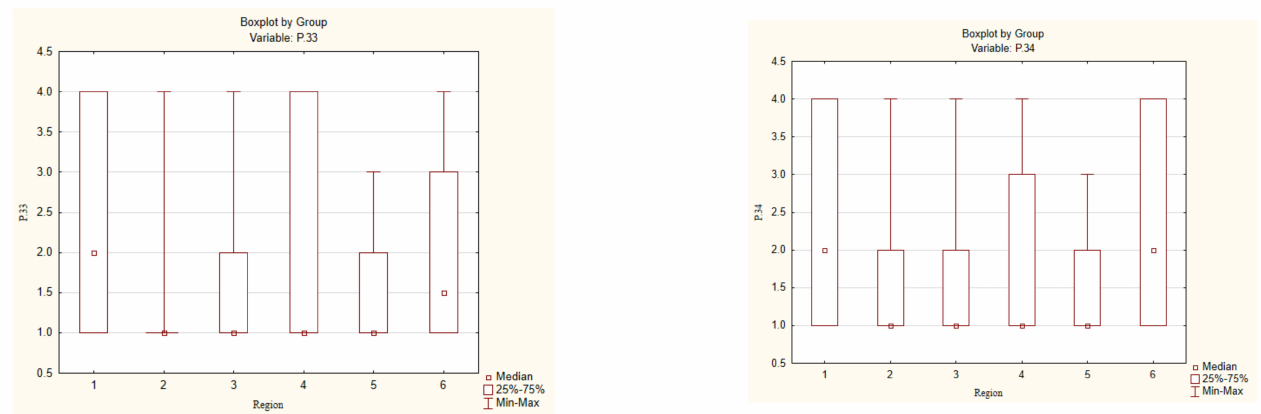
Figure 12. Box and whisker diagrams by practices P33 (Throwing away kitchen garbage after it has dried), P34 (Using receptacle instead of plastic bag), from the categories “No plastic” and “Waste management”.